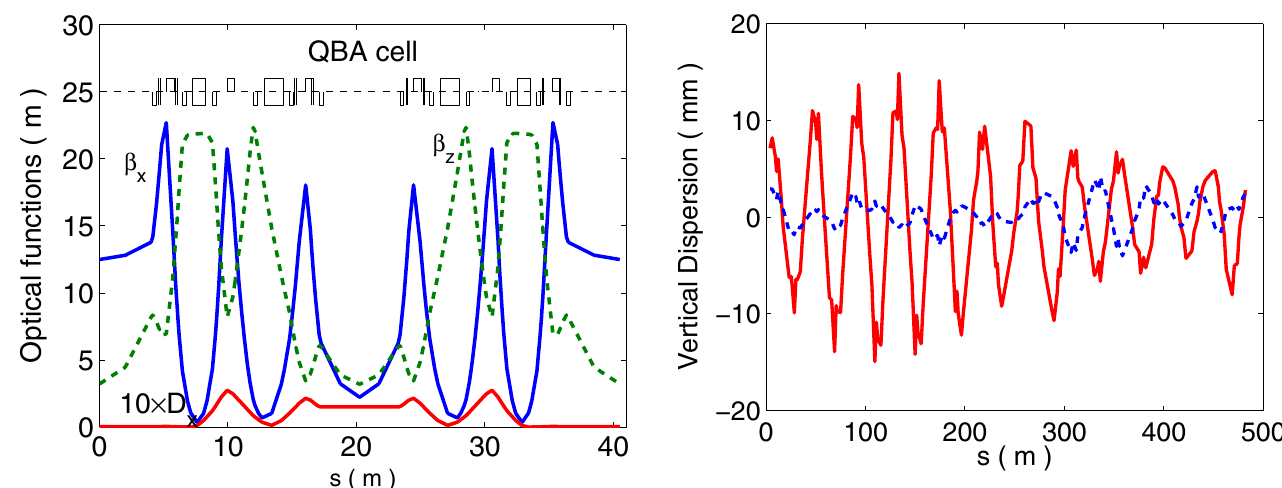
FIG. 7. (Color) Optical functions for a section of a quadruple- bend achromatic lattice [1].